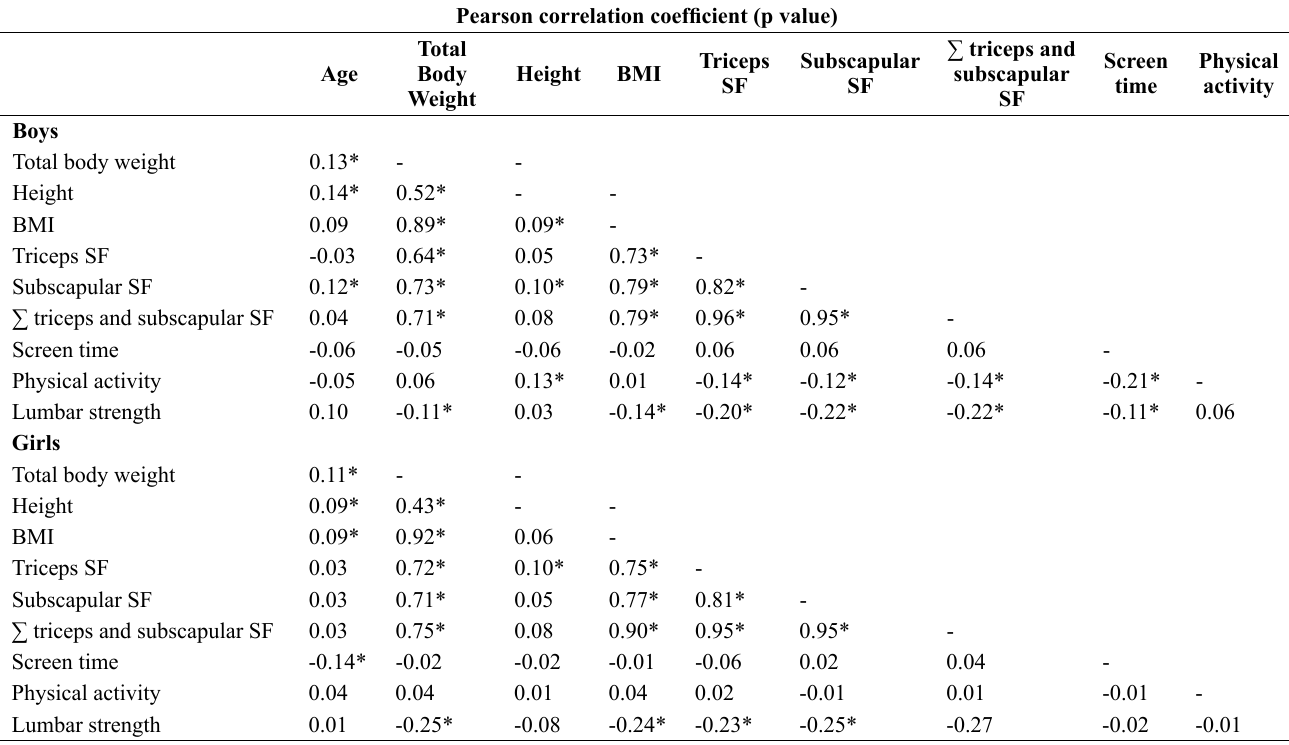
Table 3. Pearson correlation coefficient among variables investigated according to the sex of adolescents.